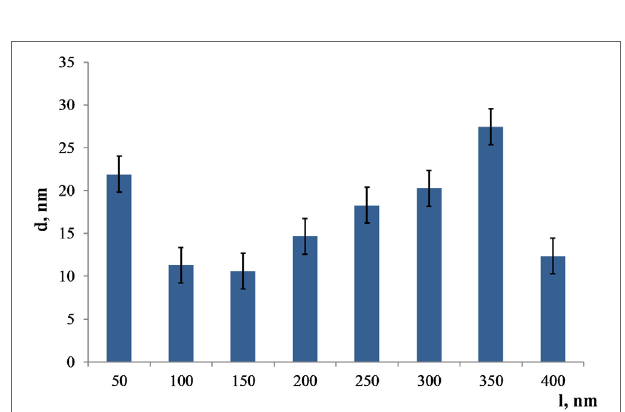
FigUre 4 | Distribution of the Zn substituted HA grain sizes from the bottom to the top (l = 400 nm) layer of the coating.